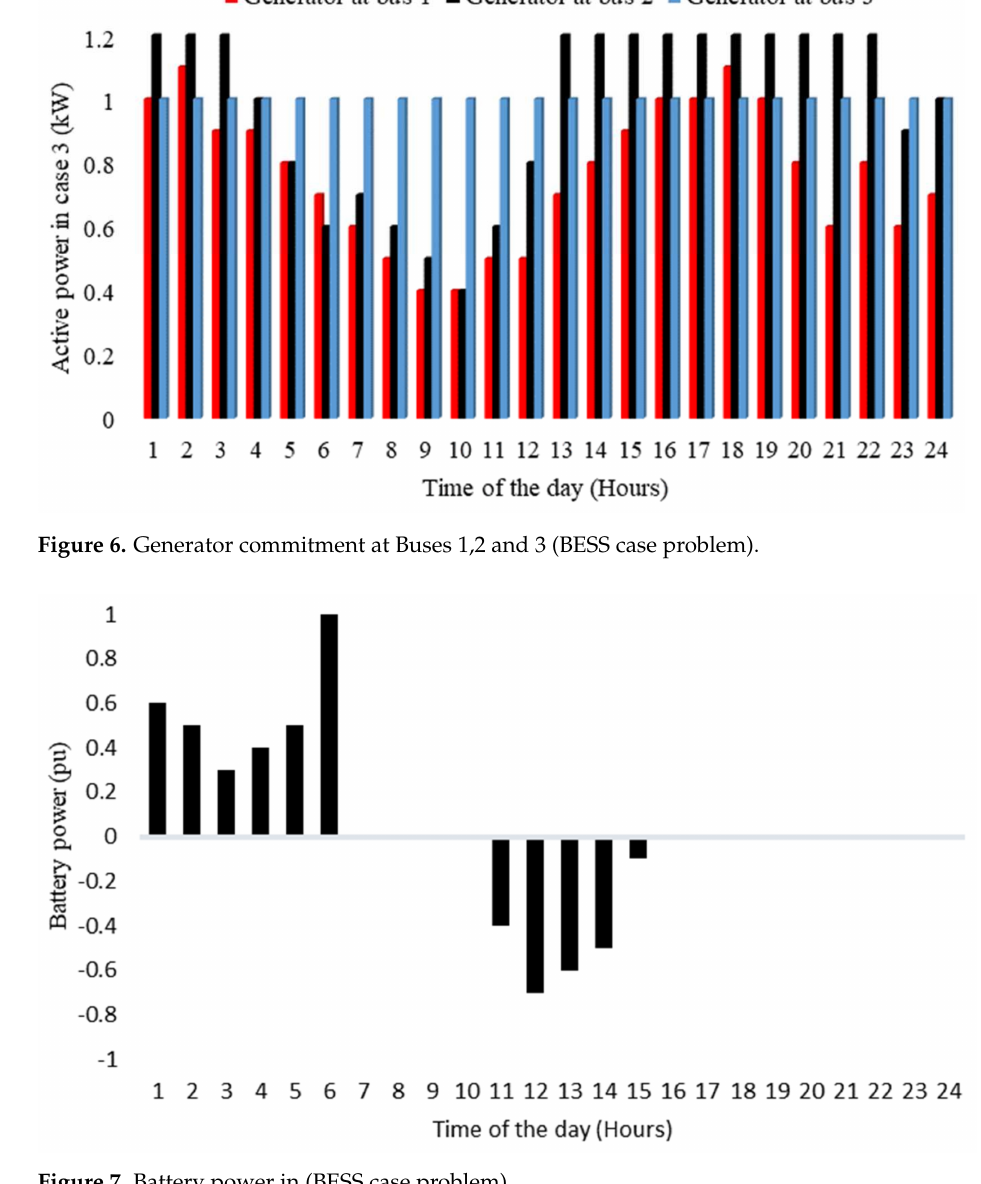
Figure 7. Battery power in (BESS case